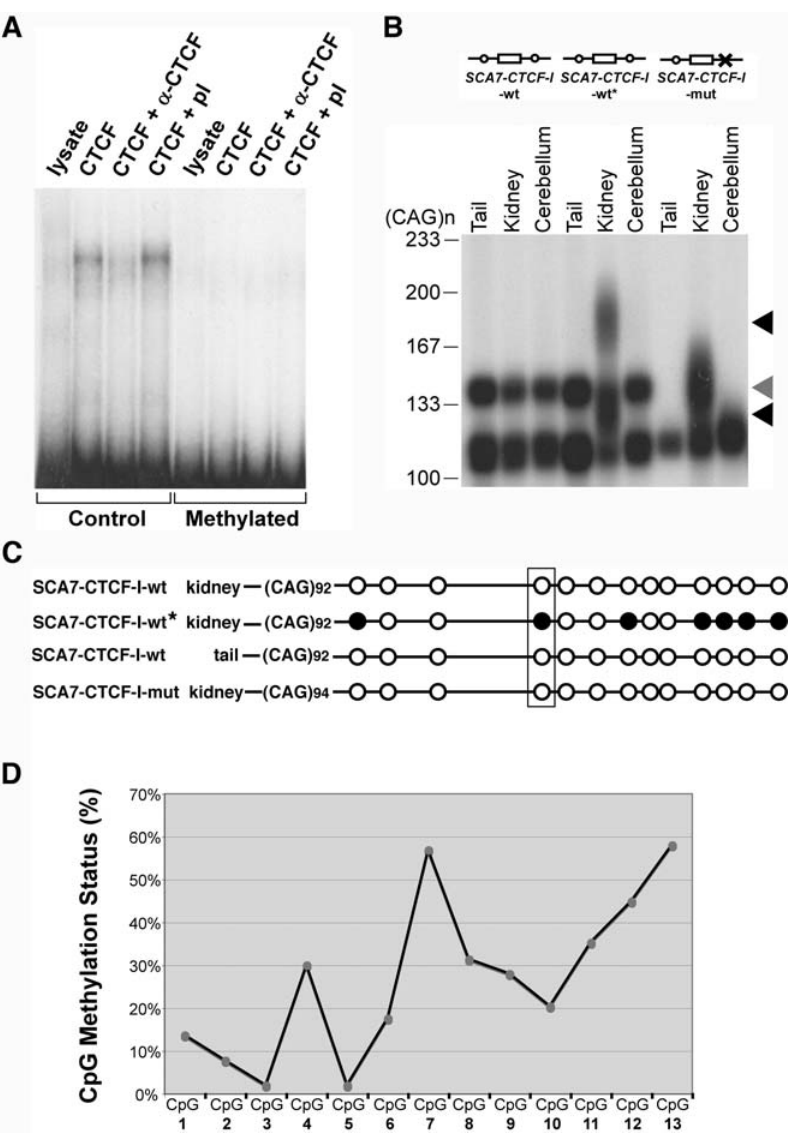
Figure 4. Epigenetic regulation of CTCF binding modulates instability at the SCA7 locus. (A) CpG methylation prevents binding of CTCF to SCA7-CTCF-I site. Electrophoretic mobility shift assays with un-methylated (control) or methylated SCA7-CTCF-I fragments, using CTCF with no antisera (CTCF), CTCF with anti-CTCF antisera (CTCF + a -CTCF), or CTCF with pre-immune sera (CTCF + pI). Arrow indicates CTCF-bound probe. (B) Prominent somatic instability in kidney DNA (black arrowheads) from a SCA7-CTCF-I -wt mouse with CTCF-I site methylation ( SCA7-CTCF-I -wt*) contrasts with somatic stability in SCA7-CTCF-I -wt mice with un-methylated CTCF-I sites. Note that SCA7-CTCF-I -wt lines display bimodal CAG repeat alleles. Prominent somatic instability is apparent in kidney DNA (gray arrowhead) from a SCA7-CTCF-I -mut mouse. All mice were 6 months of age. (C) Kidney DNAs from the SCA7-CTCF-I -wt* mouse are highly methylated. Circles, CpG dyads; open circles, unmethylated; filled circles; methylated. Box highlights core CTCF binding site contact residue, based upon footprinting analysis. Diagrammed epigenotypes summarize results for five SCA7- CTCF-I -wt mice, eight SCA7-CTCF-I -mut mice, and the SCA7-CTCF-I -wt* mouse, and were consistent for at least 75% of all sequenced clones (n=10 2 12/sample). (D) Liver DNAs from control SCA7-CTCF-I -wt mice are methylated. Bisulfite sequencing of the SCA7-CTCF-I region was performed upon liver DNAs from three SCA7-CTCF-I -wt mice at one year of age (n=17 clones/mouse), and CpG methylation determined for the 13 CpG dyads in the SCA7-CTCF-I region. A number of CpG dyads, including the CpG-4 CTCF contact site, exhibit moderate to high levels of